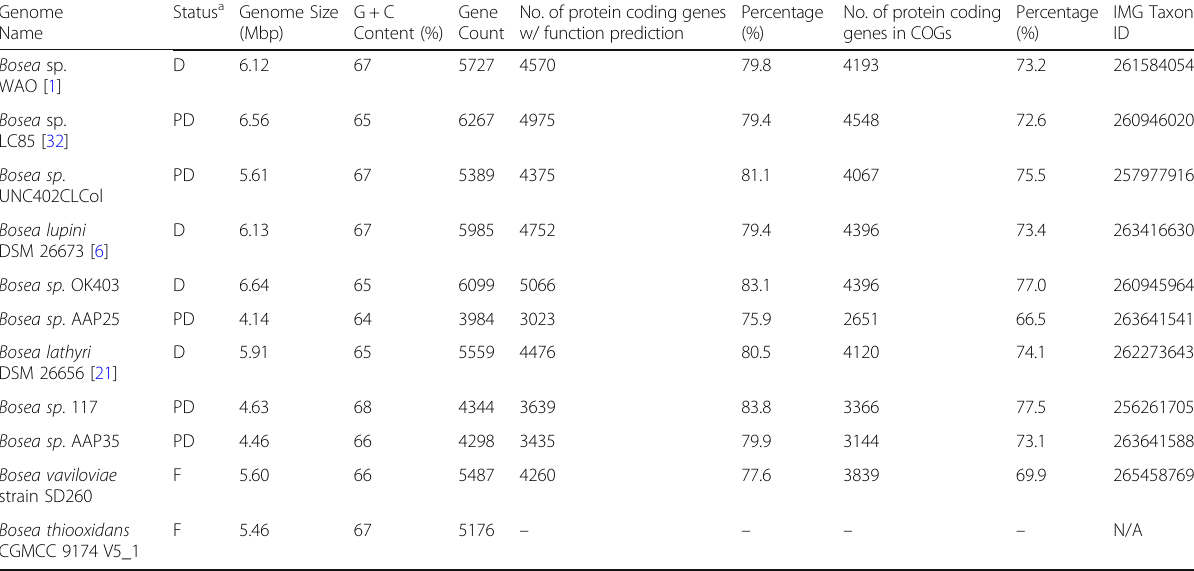
Table 5 Comparison of basic genome features of Bosea spp . Genome Name